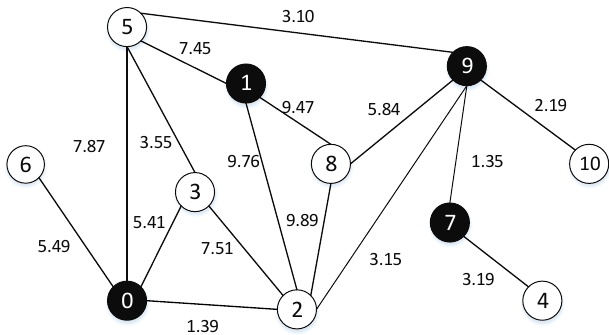
Figure 1. An example of dominating set on the graph.